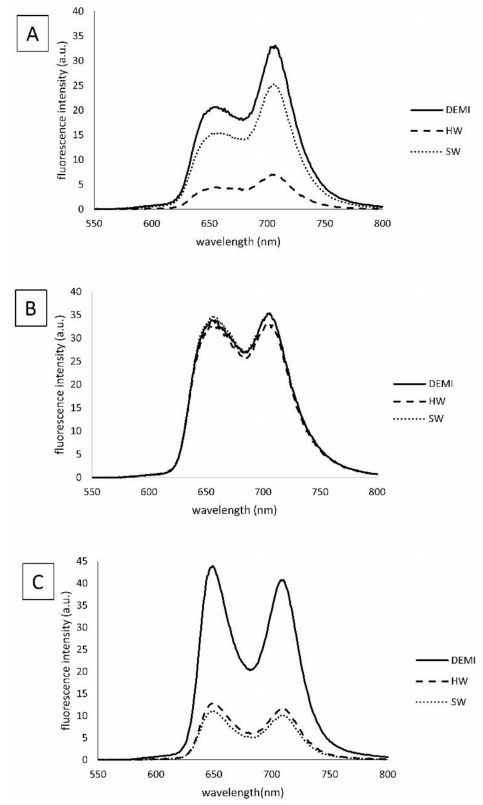
Figure 3. Fluorescence spectral characteristics of TMPyP3 ( A ), TMPyP3-CH 3 ( B ), and TMPyP3- C 17 H 35 ( C ) in DEMI (full line), soft water (dashed line), and hard water (dotted line). All measure- ments were performed in 1 µ M solutions.